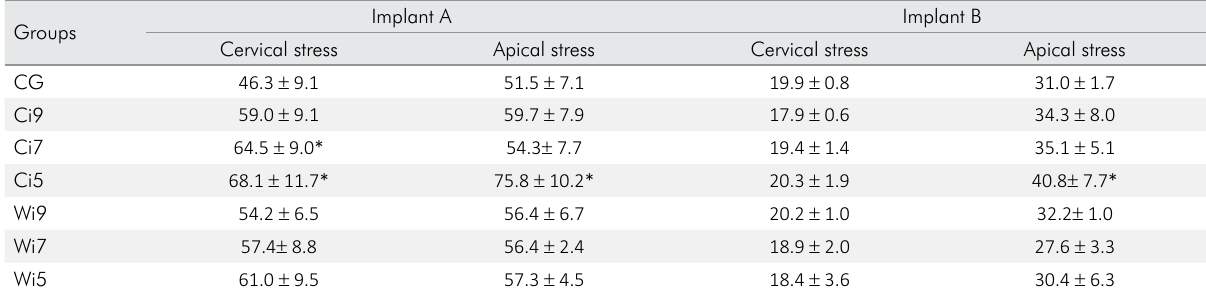
Table 2. Shear stress values (kgf) to implant A (closer to the load side) and implant B (subsequent implant). Groups